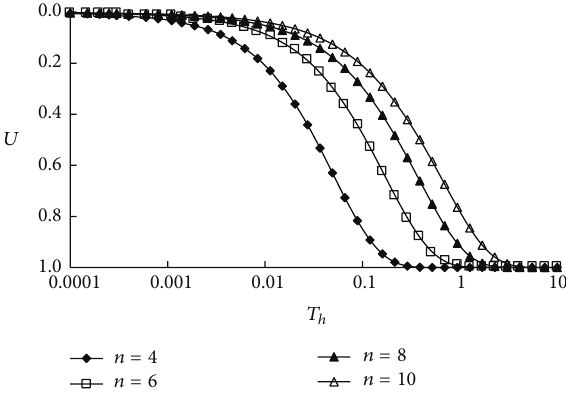
Figure 4: Influence of 𝑛 on consolidation process.